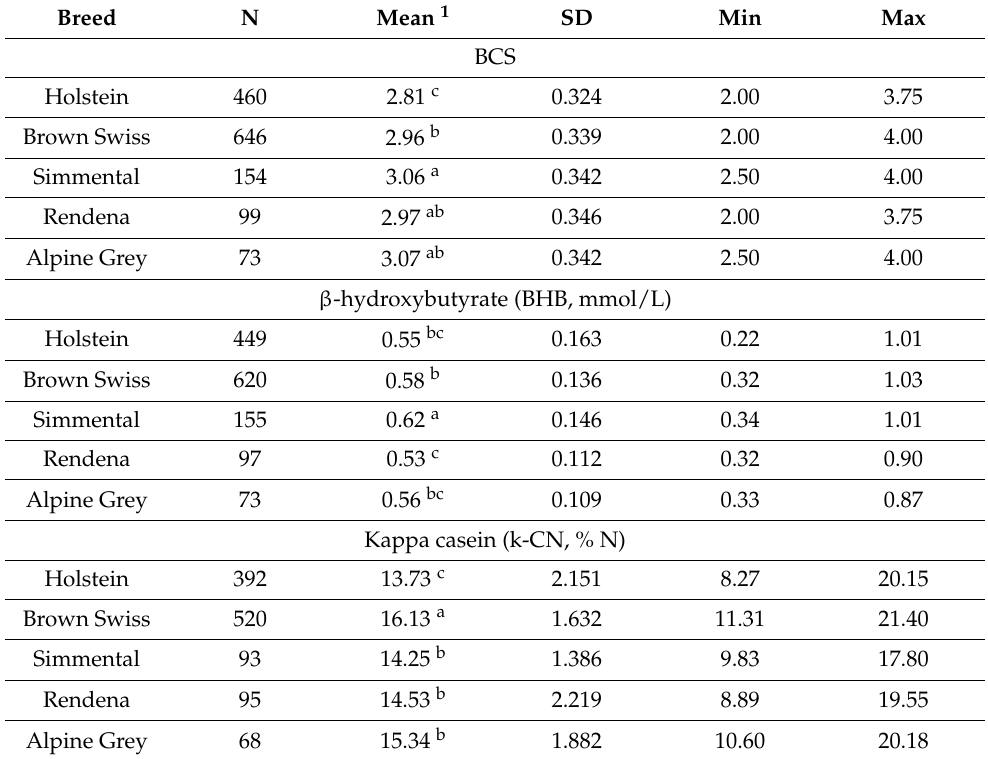
Table 1. Descriptive statistics for body condition score (BCS), blood β -hydroxybutyrate (BHB, mmol/L), and kappa casein (k-CN, % N) assessed in specialized and dual-purpose